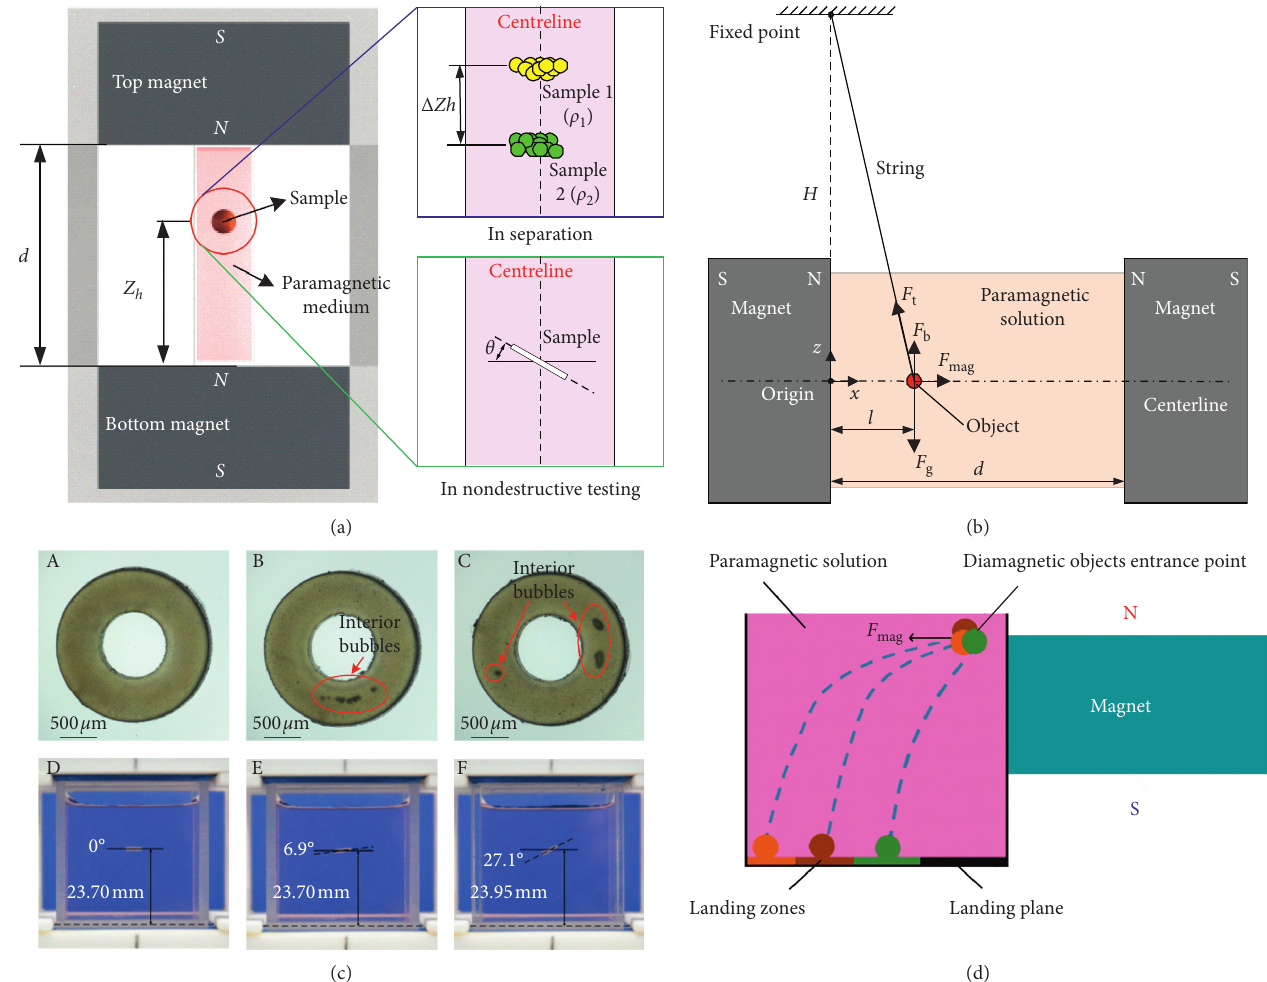
Figure 9: (a) Schematic view of the magnetic levitation detection device [82]. (b) Horizontal magnetic levitation for enlarging density measurement range [83]. (c) Samples and their levitation posture and position in MagLev device [82]. (d) A novel separation device using the magnetic levitation method